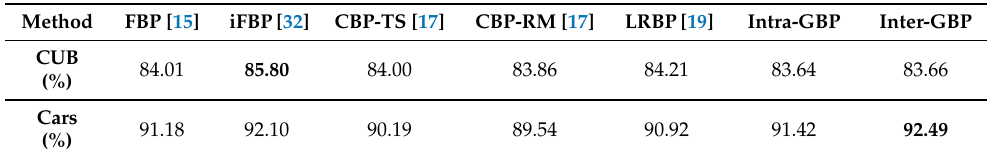
Table 4. The performances of different compact bilinear pooling methods on CUB dataset and Stanford Cars dataset. (Based on